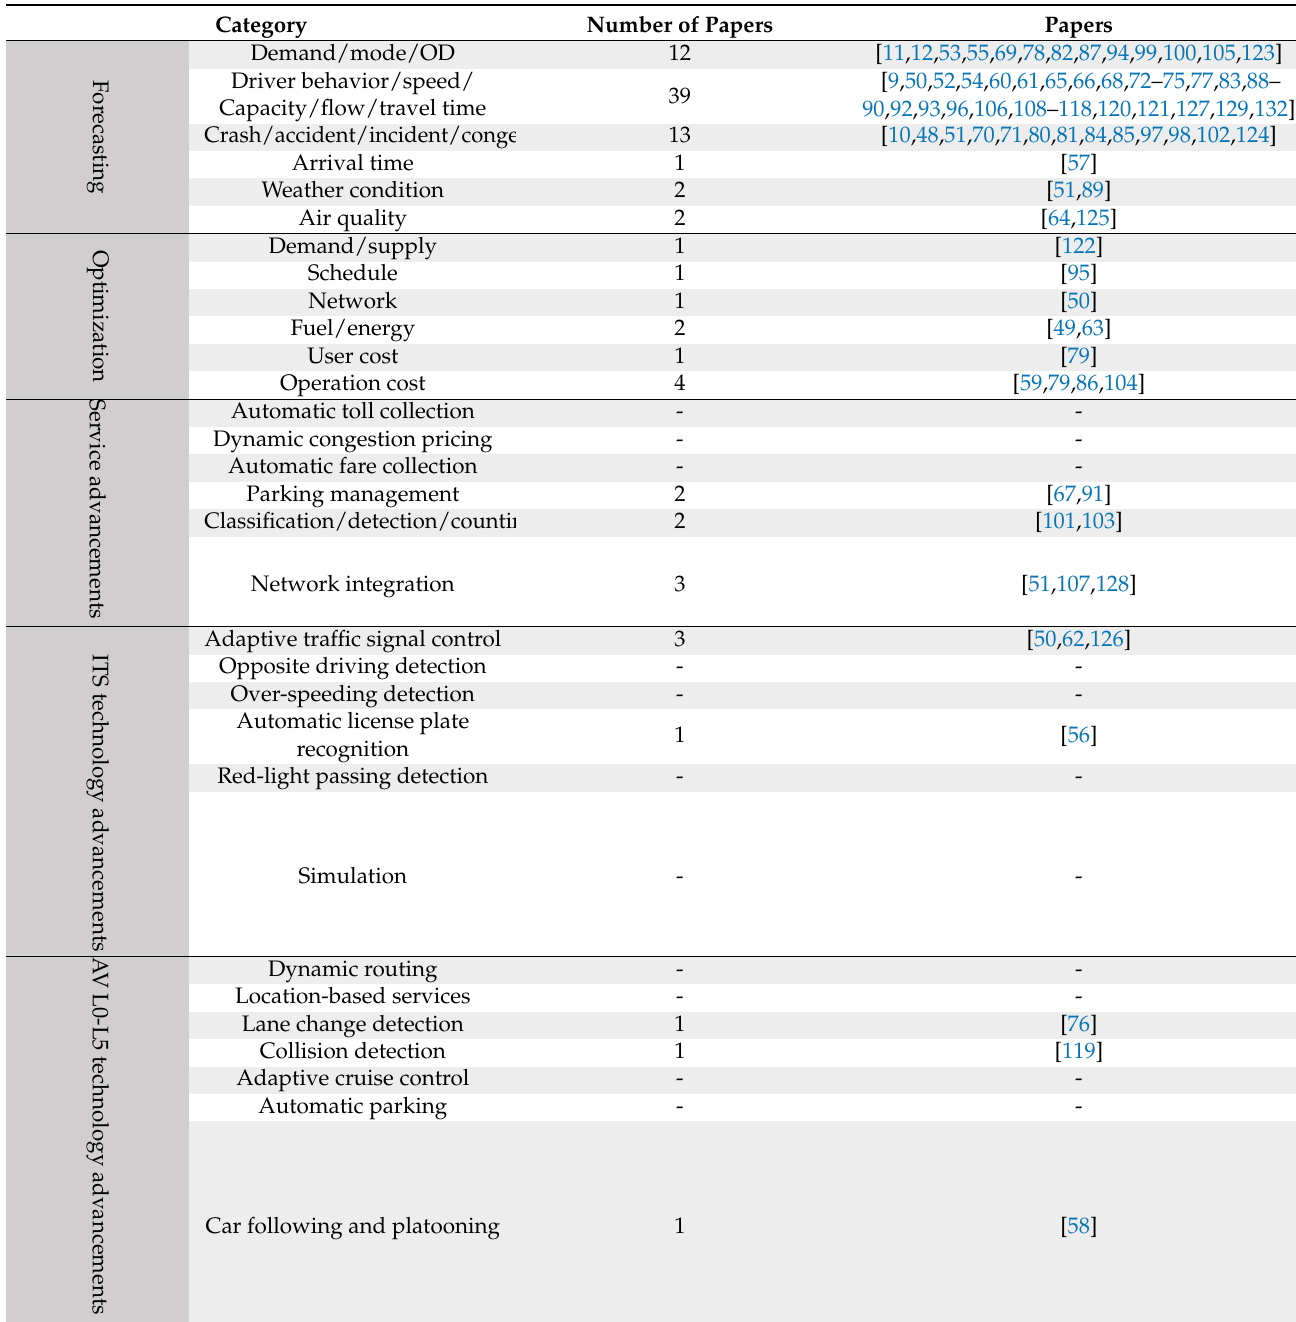
Table 3. Research papers’ distribution in STS application